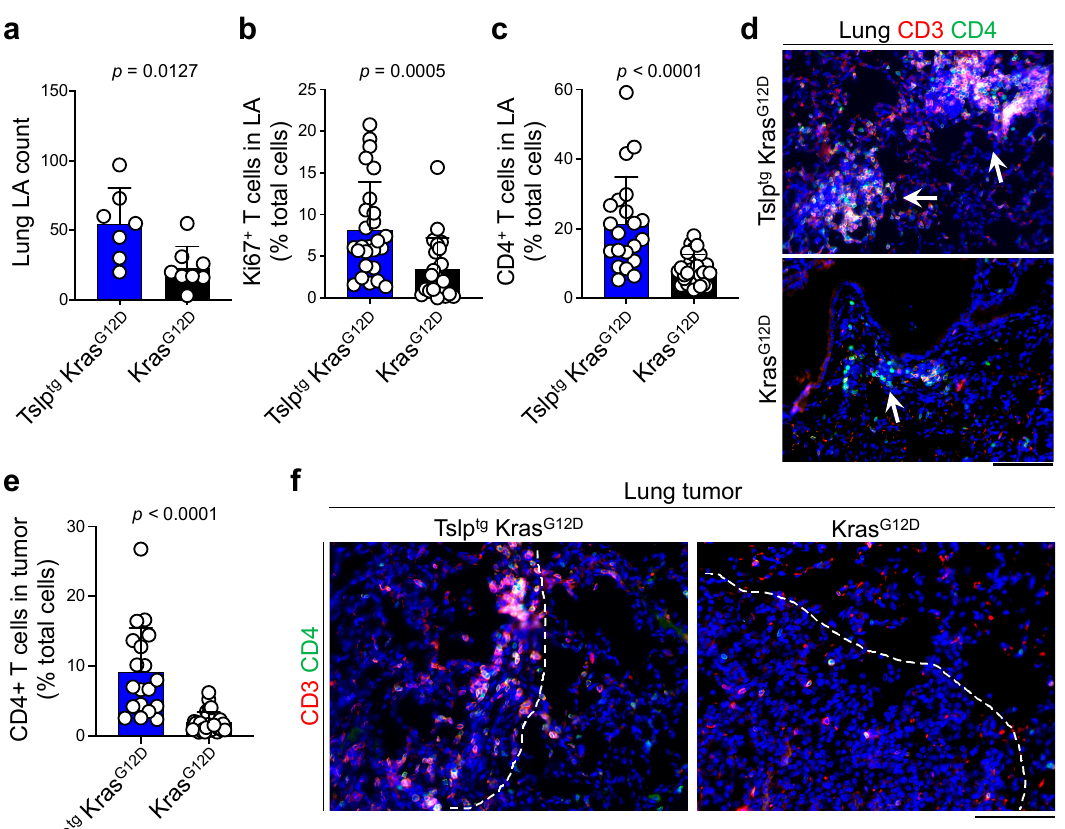
Figure 3. Tslp tg Kras G12D lungs and tumors are highly infiltrated by CD4 + T cells. ( a ) The number of lymphoid aggregates (LA) in Tslp tg Kras G12D ( n = 7) and Kras G12D ( n = 8) lungs. ( b ) Percentage of Ki67 + T cells out of total cells in Tslp tg Kras G12D ( n = 26) and Kras G12D ( n = 23) lung lymphoid aggregates. ( c ) Percentage of CD4 + T cells out of total cells in Tslp tg Kras G12D ( n = 21) and Kras G12D ( n = 29) lung lymphoid aggregates. ( d ) Representative images of CD3 (red) and CD4 (green) stained lymphoid aggregates in Tslp tg Kras G12D and Kras G12D lungs. Arrows point to the lung lymphoid aggregates. Note the larger sizes of lymphoid aggregates in Tslp tg Kras G12D mice. DAPI (blue) stains the cell nuclei, scale bar: 100 µ m. ( e ) Percentage of CD4 + T cells out of total cells in Tslp tg Kras G12D ( n = 19) and Kras G12D ( n = 28) lung tumors. ( f ) Representative images of CD3 (red) and CD4 (green) stained tumors in Tslp tg Kras G12D and Kras G12D lungs. Dashed lines highlight the boundaries of the lung tumors. DAPI (blue) stains the cell nuclei, scale bar: 100 µ m. Bar graphs show mean + SD, Mann Whitney U